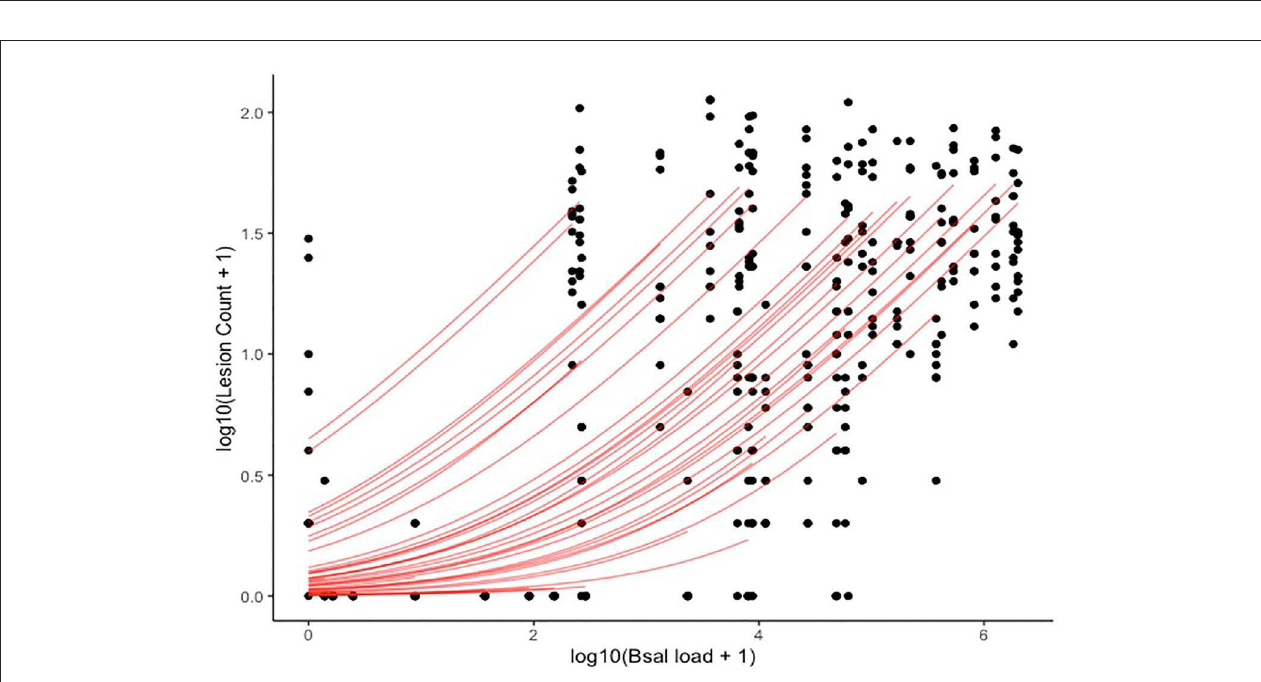
FIGURE14 Plot of log10(Lesion count + 1) (y-axis) and log10( Bsal load + 1) (x-axis). Black points represent histologic lesion count at each of 10 standardized anatomical sections examined for each Batrachochytrium salamandrivorans ( Bsal ) infected Taricha granulosa . Red lines represent individual level relationships as predicted by our statistical model. As each individual only had one Bsal qPCR load (at necropsy), but multiple lesion counts due to the multiple sections, a unique slope cannot be inferred for the relationship between Bsal load and lesion count for each